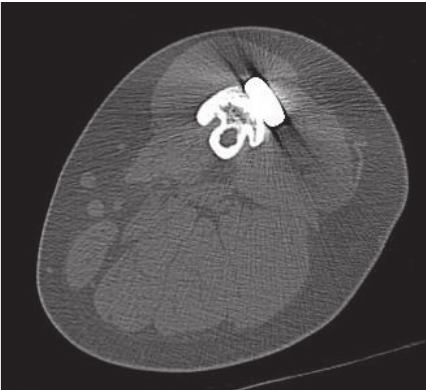
Figure 4: A CT scan at 39 months after surgery. Bridging bone formationfromthehypertrophicinlaidfibulatothefrozenautograft is